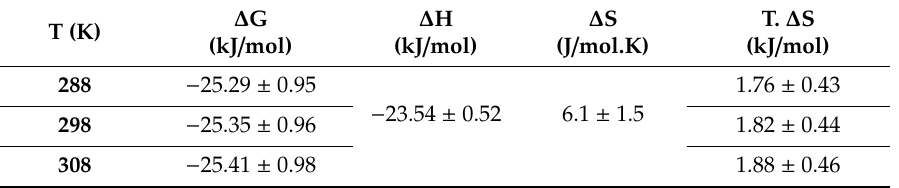
Table 2. Thermodynamic parameters of the complex RSA–piperine at 288 K, 298 K, and 308 K.